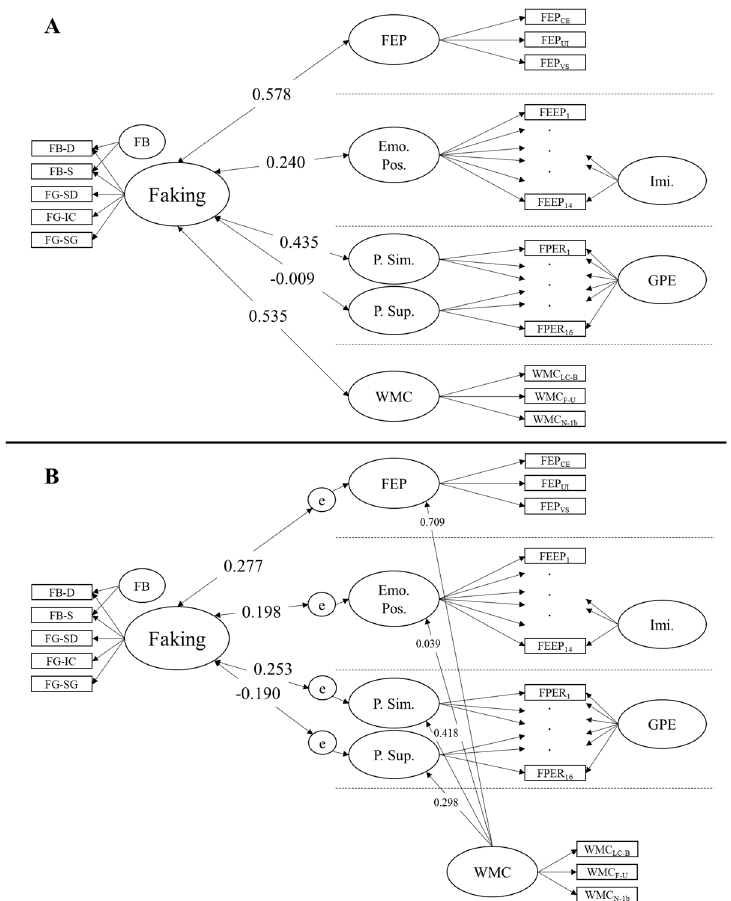
Figure 2. Confirmatory factor analyses to estimate the correlations between faking ability and covariates (schematic measurement models) before ( A ) and after ( B ) controlling for general mental ability. Dashed lines indicate that models were estimated separately per covariate. FB = faking bad; FG = faking good, D = depression, S = somatization; SD = software developer; IC = insurance policy processing clerk; SG = security guard; FEP = facial emotion perception ability; CE = composite emotions; UI = upright-inverted; VS = visual search; Emo. Pos. = emotion posing ability; Imi. = imitation; FEEP = facial emotion expression posing ability; P.Sim = pain simulation; P.Sup. = pain suppression; GPE = general pain expression; FPER = facial pain expression regulation; WMC = working memory capacity; LC-B = letter-color binding; F-U = figural updating; N-1b = numerical 1-back. Pain regulation ability was also modeled according to prior work (Geiger et